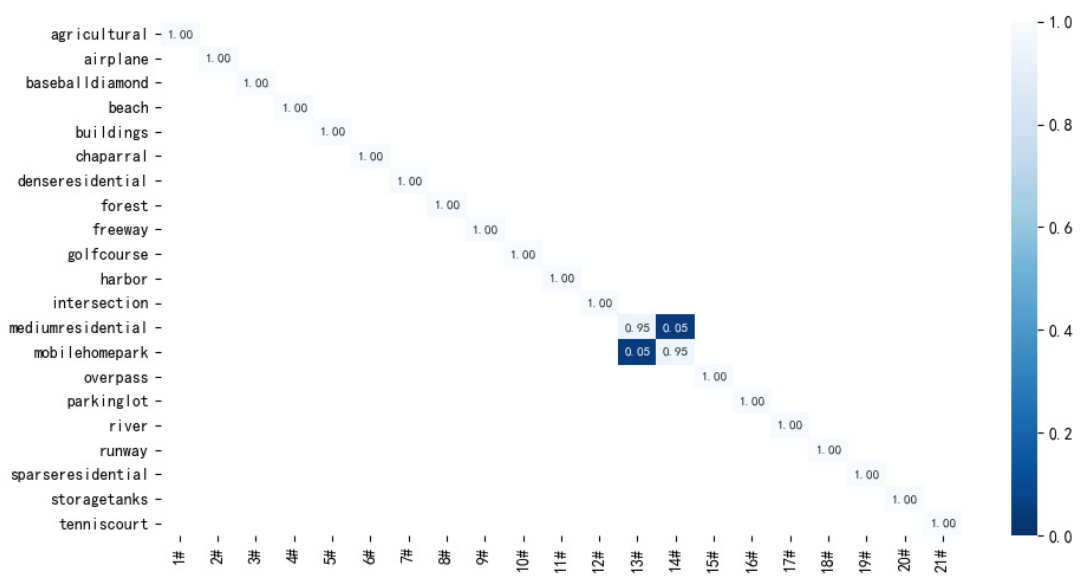
Figure 10. Confusion matrix of the proposed method on UCM dataset with 80% training ratio.